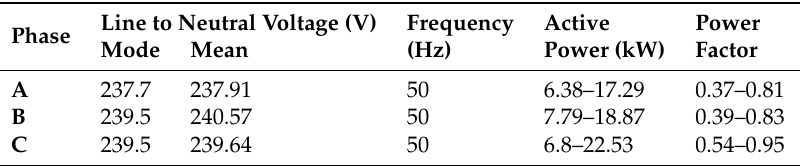
Table 13. Grid parameters: football